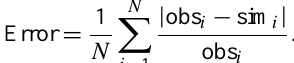
Figure 3. Spatial fields of kriged adjustment factors ( R SH on-road diesel combustion, on-road gasoline combustion, and wood stove sources for 4 January 2004. Adjustment factors at CSN mon- itors (denoted by circles) were generated using hybrid (CTM–RM) source apportionment. Note that each panel has a different